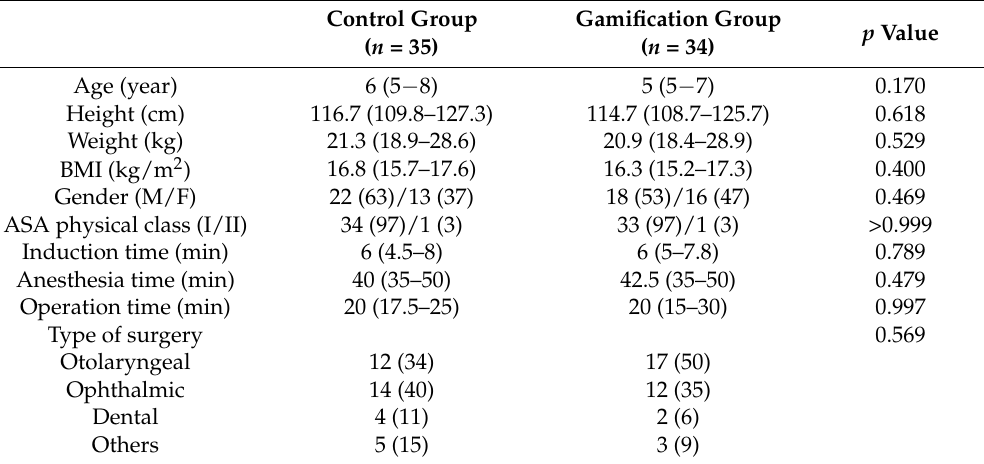
Figure 2. Consort diagram. Table 1. Patients, anesthesia and surgery characteristics.